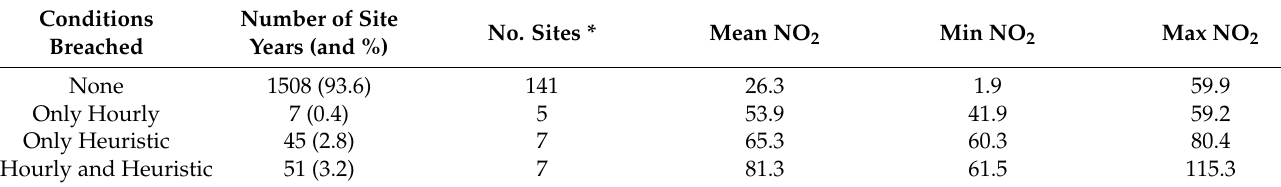
Figure 1. The number of hours where NO 2 exceeded 200 µ g/m 3 against annual mean NO 2 for each site-year datapoint. Open points have more than 18 exceedances and closed points have less than or equal to 18 exceedances. A horizontal black line is drawn at 18 h for clarity. Points in the top right hand corner are all plotted at 400 h to compress the y-space needed for the graph and the actual values are shown in labels. A vertical line is shown at 60 µ g/m 3 which represents the heuristic that is supposed to separate closed from open datapoints. Table 1. Summary of data for all site types in the AURN dataset, examining the cartesian product of whether the heuristic threshold is met (>60 µ g/m 3 annual mean) and whether the hourly threshold is met (more than 18 h >200 µ g/m 3 ). The last four columns show mean, minimum, maximum, and standard deviation of measured NO 2 for each category (in µ g/m 3 ). * A site can be in more than one set because it can differ from year-to-year and so the total of the column exceeds the total number of sites (143).